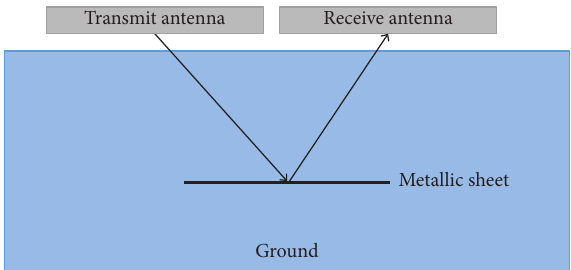
Figure 14: The block diagram of GPR test arrangement in the lab.